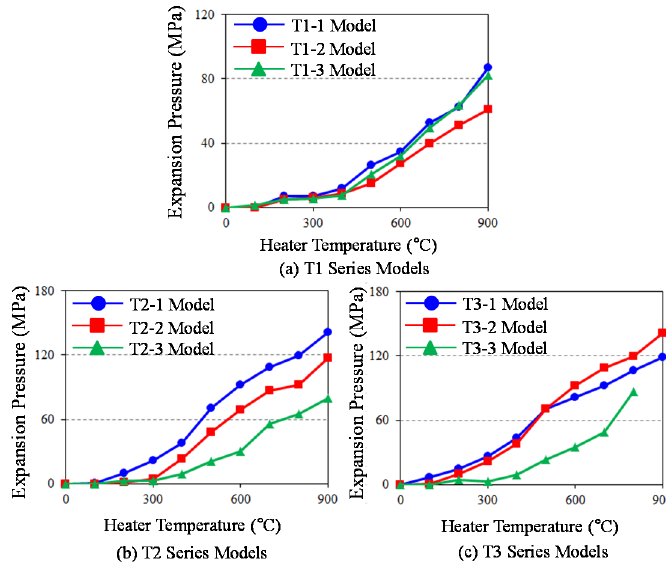
Figure 9. Temperature versus calibrated expansion pressure curves.